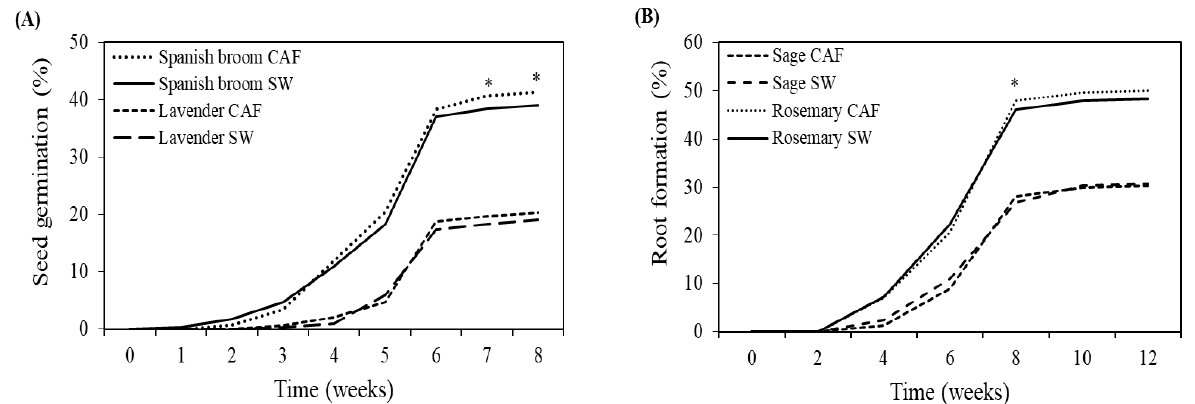
Figure 1. Effect of different substrates on the growth capacity in ornamental plants. ( A ) Seed germination (%) of Spanish broom and lavender sowed in recycled cellulose acetate filters (CAF) or stone wool (SW) substrates. ( B ) Root formation (%) of rosemary or sage stem cuttings propagated in CAF or SW substrates. Data are means of 3 replicates of 100 seeds or cuttings. Asterisks represent significant differences ( p < 0.05) between substrates.